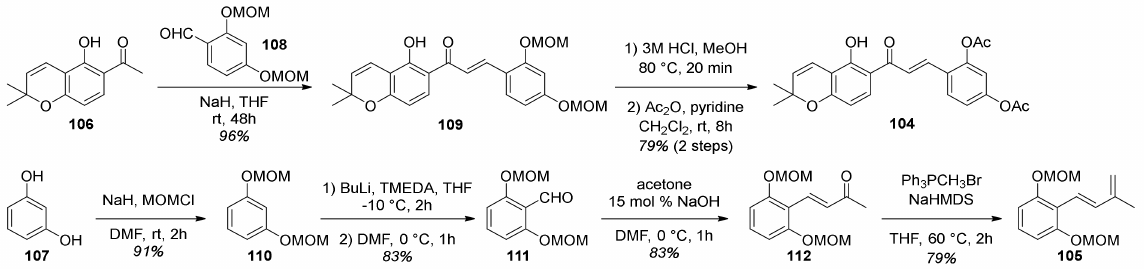
Figure 31. Retrosynthetic approach towards sorocenol B ( 19 ).